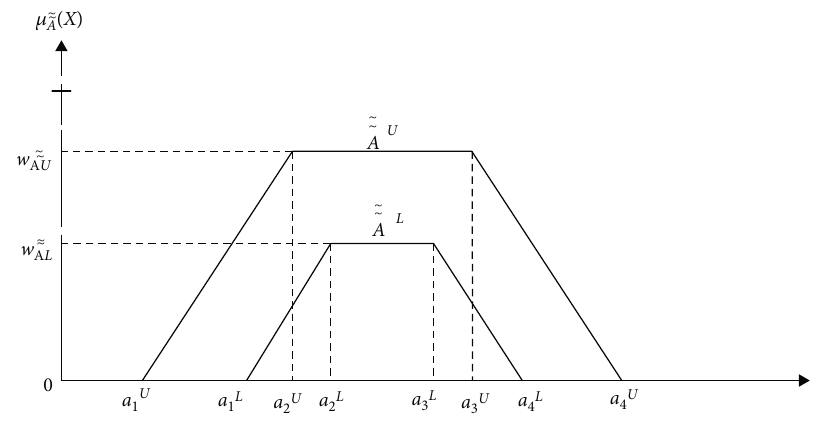
Figure 3: Interval-valued trapezoidal fuzzy